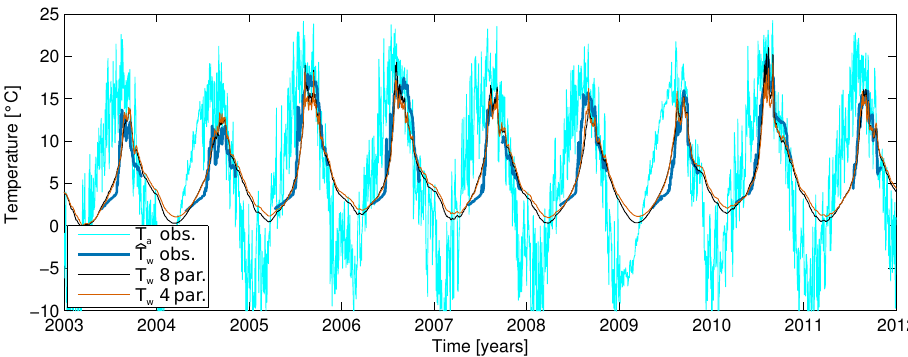
Fig. 7. Comparison between simulated and observed surface water temperature during the validation period 2003–2011 (NDBC simulation). Simulated curves refer to the full eight-parameter and the simplified four-parameter models. Observed air temperature data are also presented with cyan line.